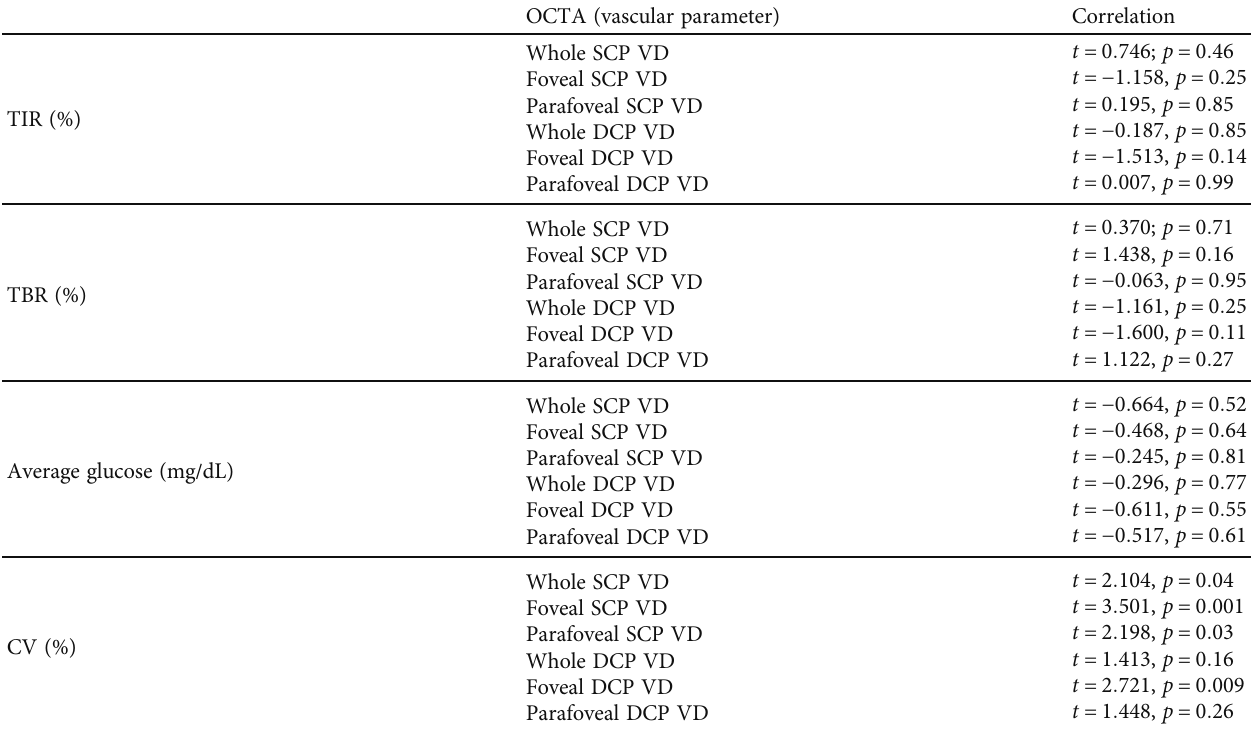
Table 4: Correlation between OCTA parameters and CGM-derived glucose metrics in type 1 diabetes after exclusion of smokers and patients with hypertension or